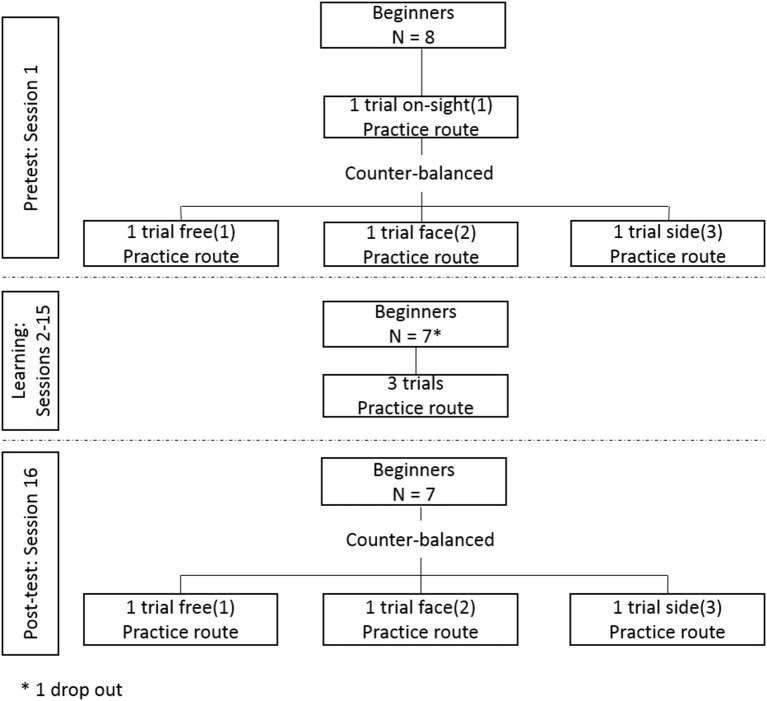
Experimental design.